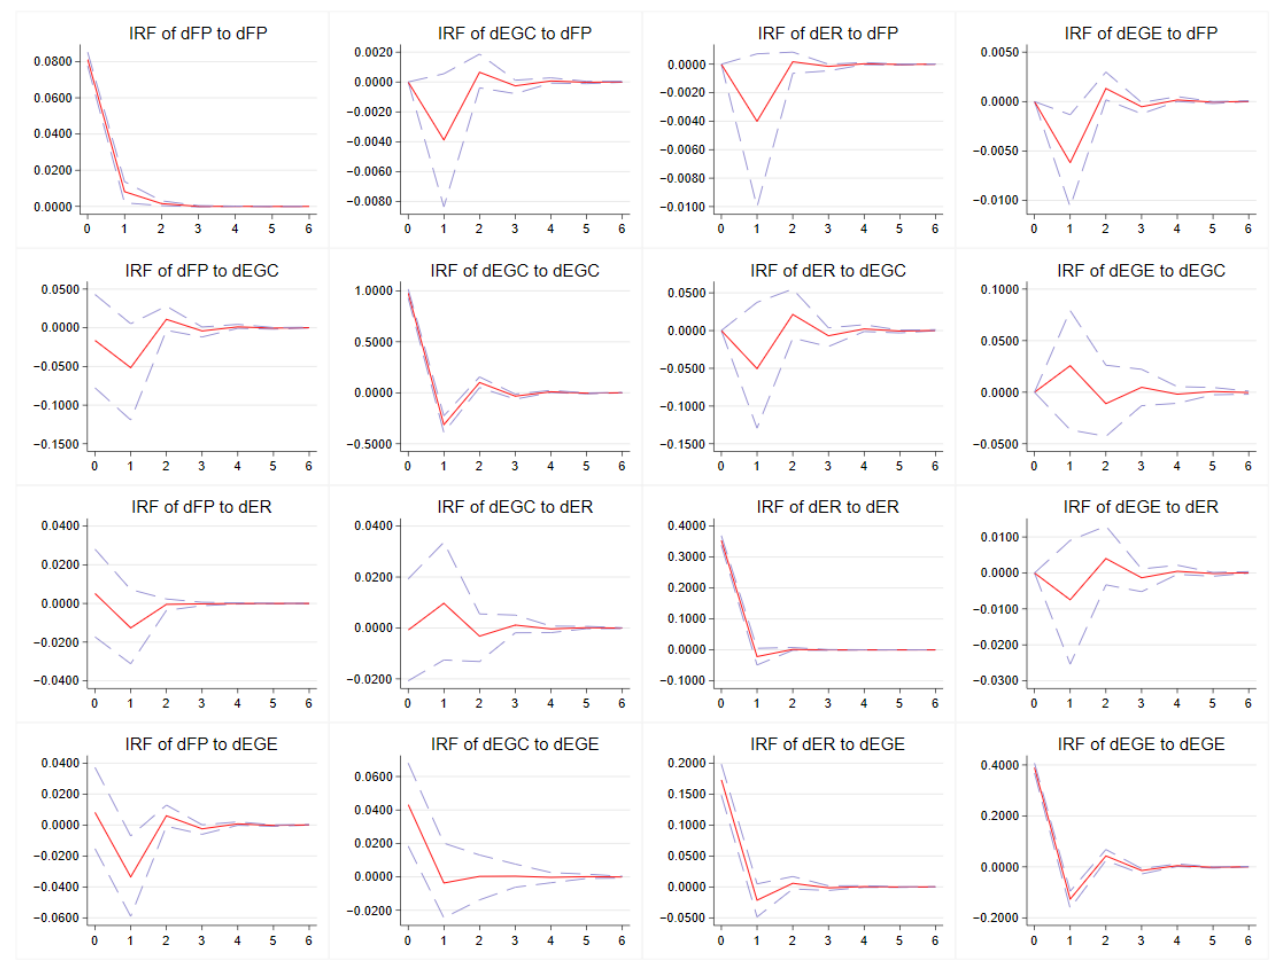
Figure 5. Impulse response results. Note: the horizontal axis is the lag order, and the vertical axis is the intensity of the response. The solid red line is the impulse response curve, and the dashed line indicates the upper and lower limits of the confidence interval.